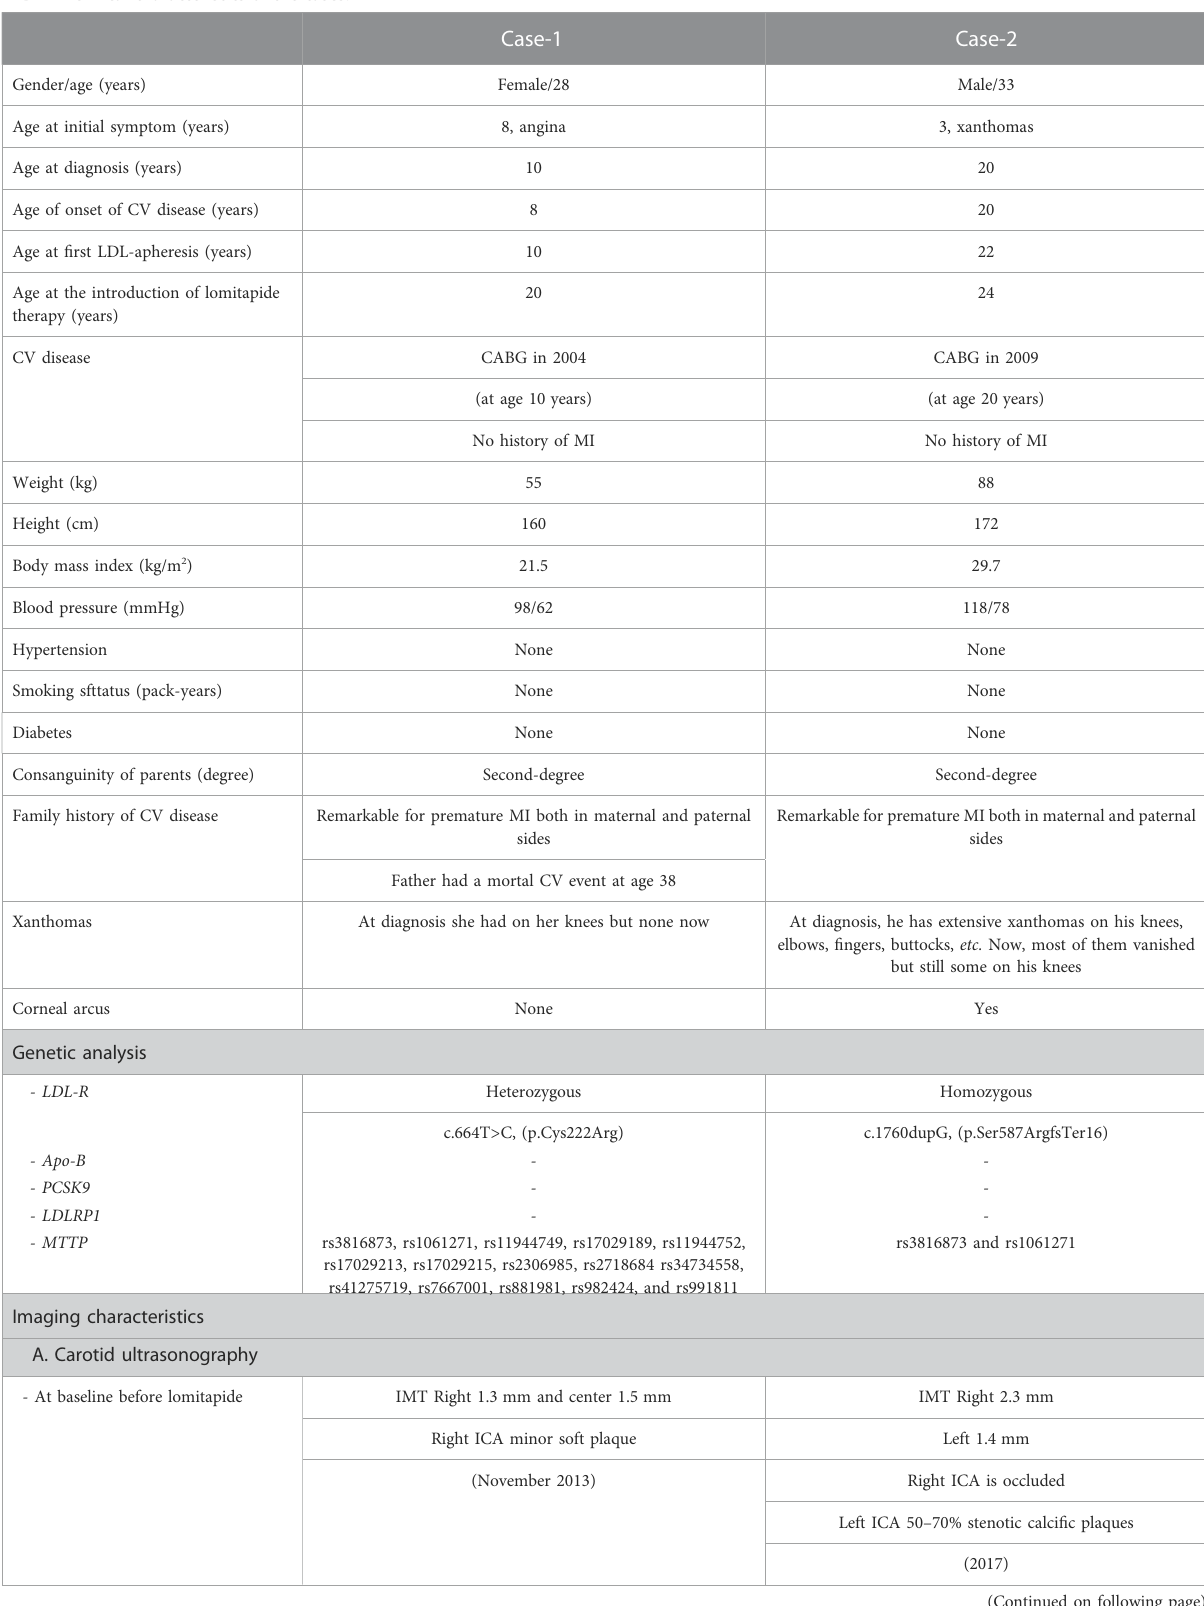
TABLE 1 Clinical characteristics of the